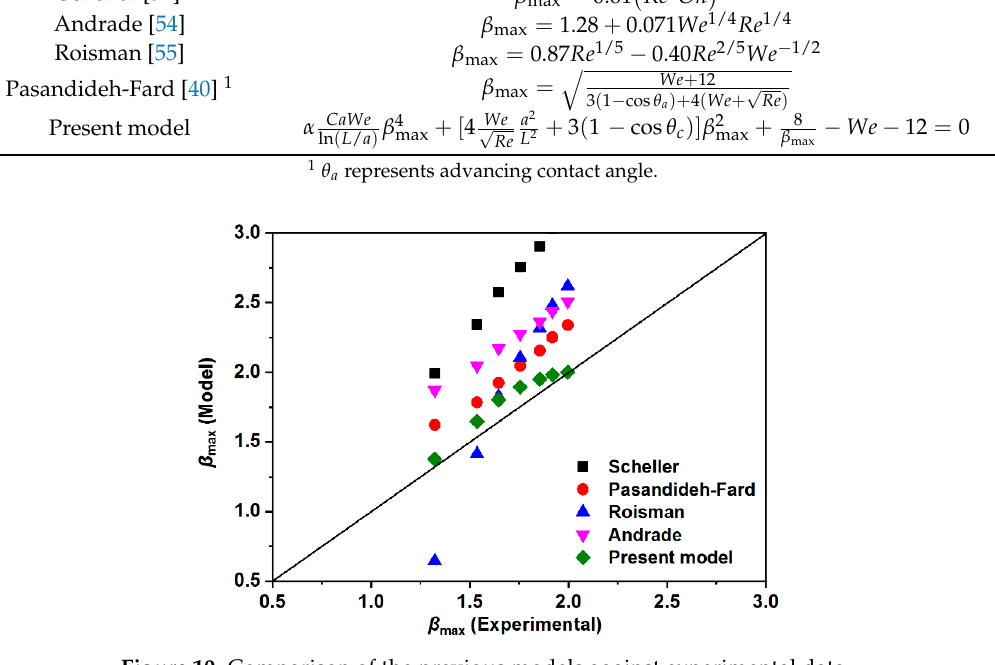
Figure 10. Comparison of the previous models against experimental data. Table 2. Summary of mean-errors and standard deviations of different prediction model.